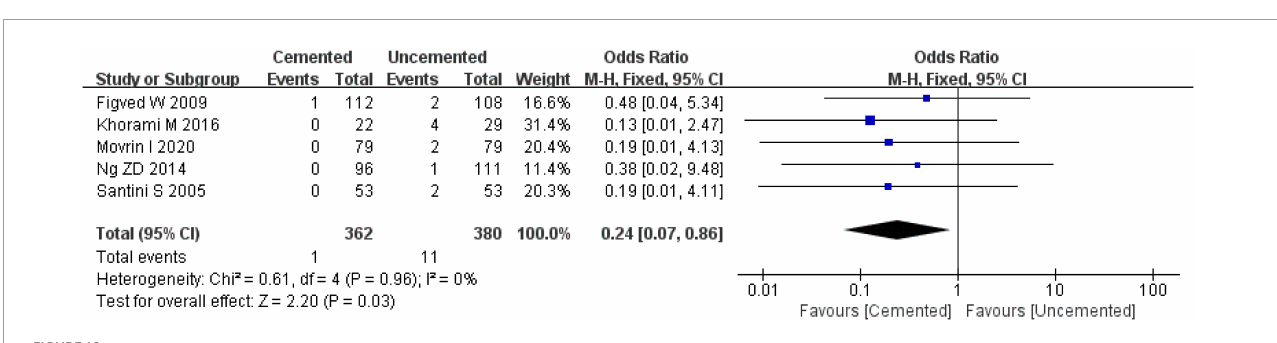
FIGURE12 Forest plot for comparison of intra-operative fractures between cemented bipolar hemiarthroplasty (CBH) group and uncemented bipolar hemiarthroplasty (UCBH) group.